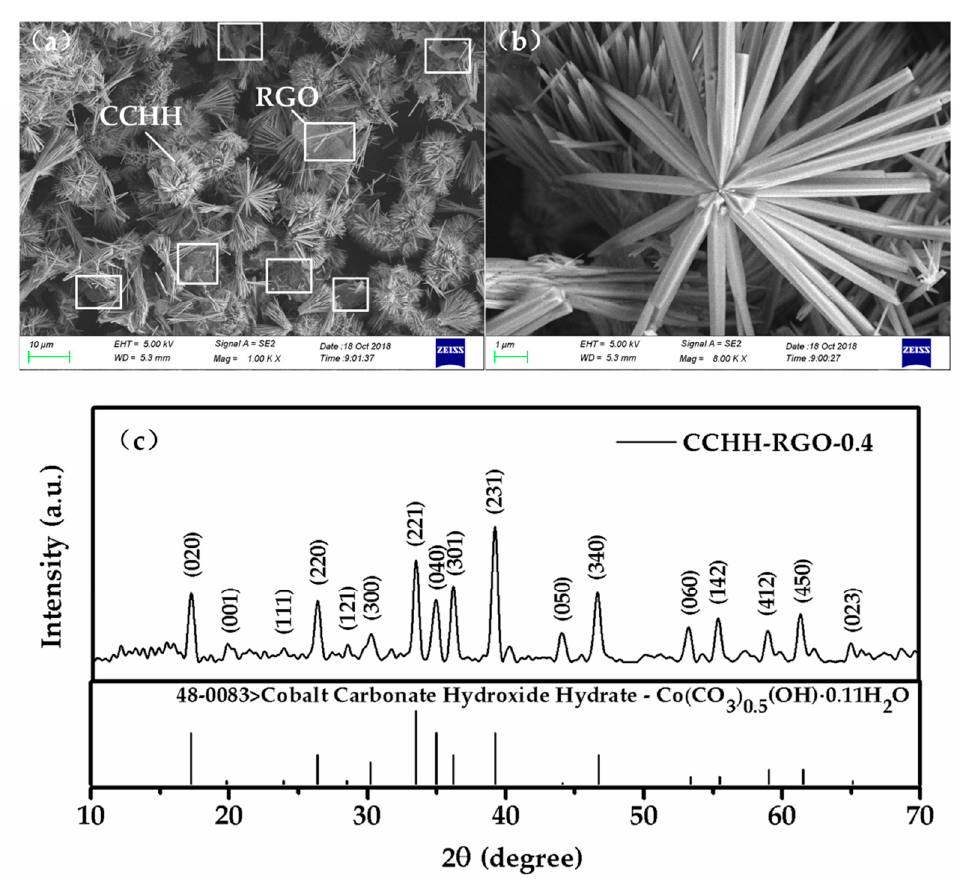
Figure 3. ( a ) Scanning electron microscope (SEM) image of CCHH-RGO-0.4; ( b ) the enlarged SEM image of CCHH-RGO-0.4; ( c ) X-ray diffraction (XRD) pattern of CCHH-RGO-0.4.